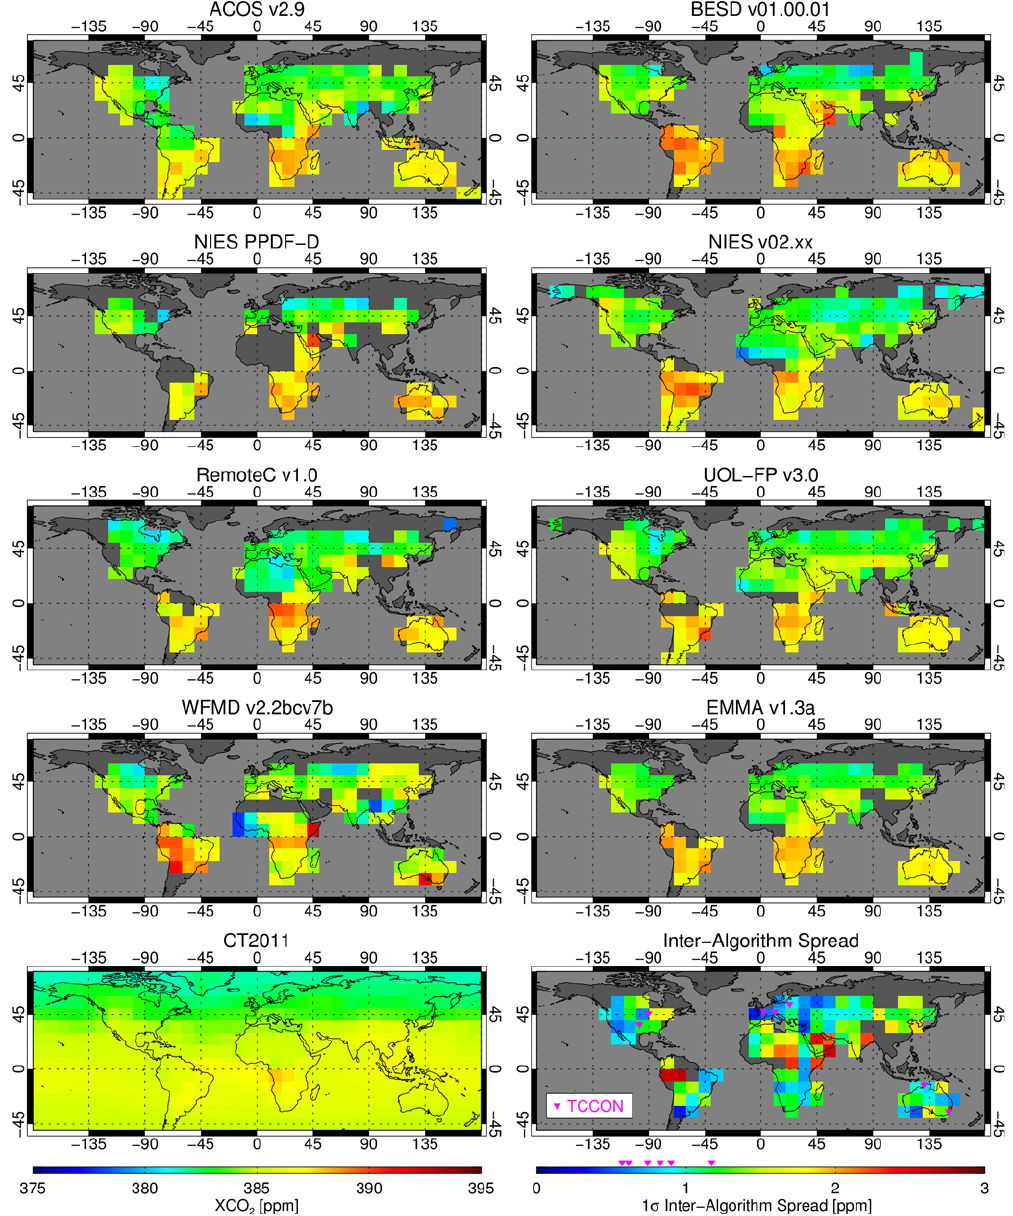
Fig. 2. Typical monthly gridded averages (September 2009) of the seven algorithms, EMMA, and CT2011 as well as corresponding inter- algorithm spread, i.e., the inter-algorithm standard